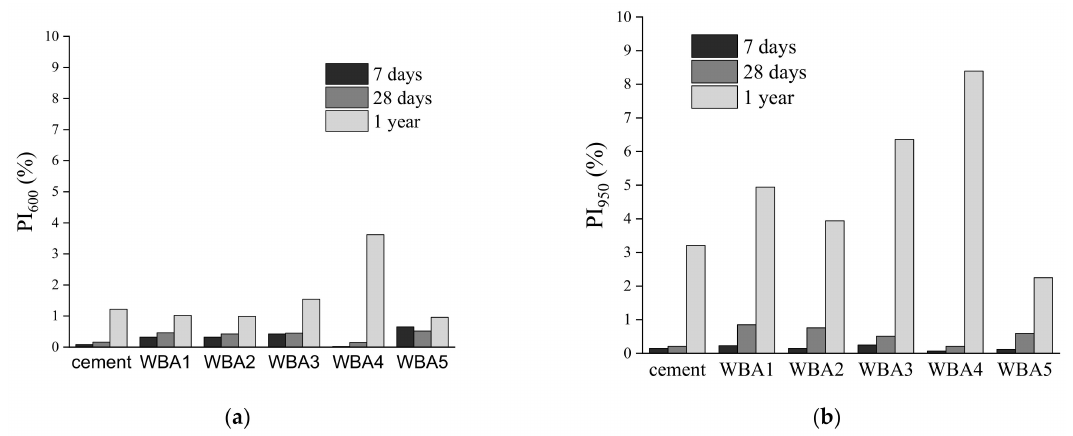
Figure 5. ( a ) PI 600 value for WBA samples (7 days, 28 days, and 1 year) for temperatures between 35 and 600 ◦ C; ( b ) PI 950 value for WBA samples (7 days, 28 days, and 1 year) for temperatures between 35 and 950 ◦ C.